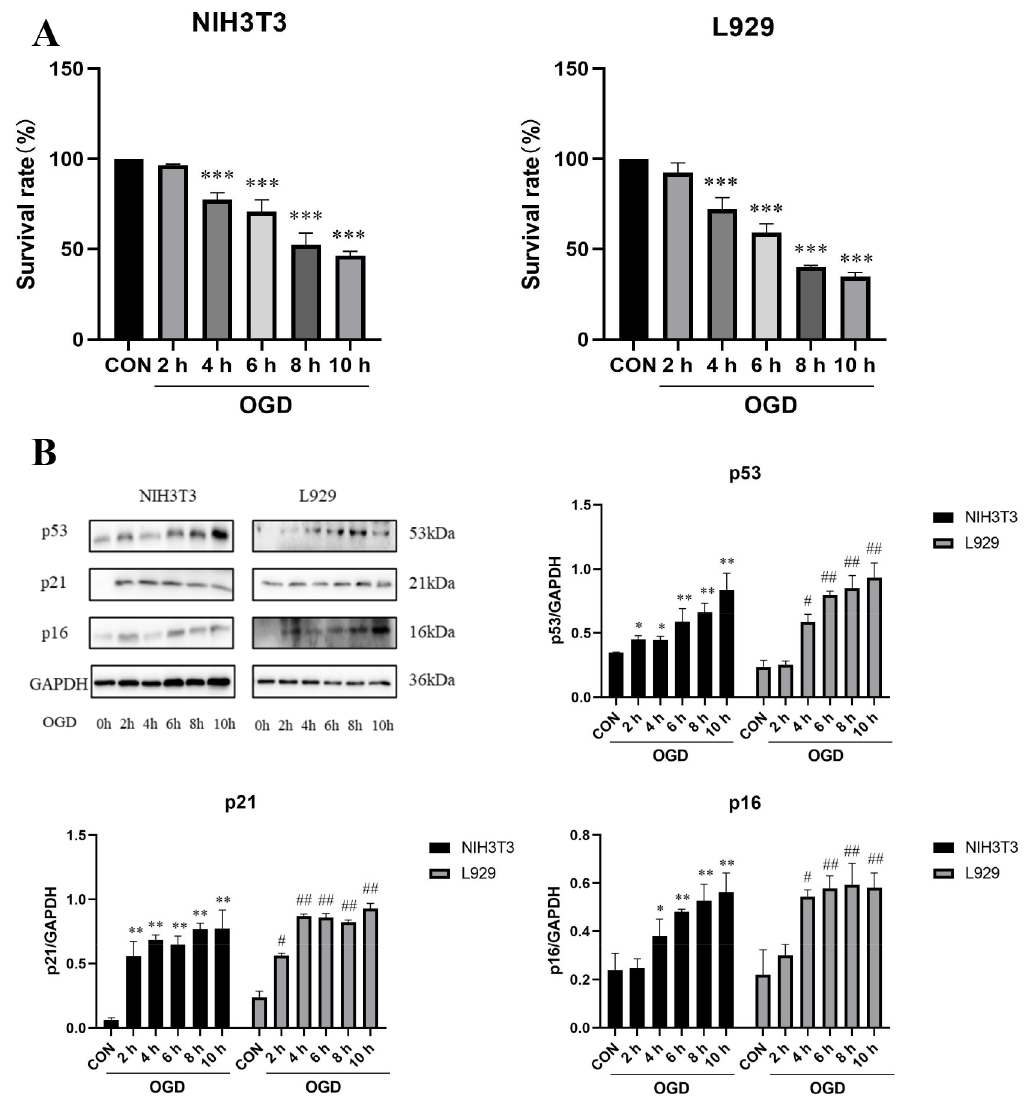
Figure 1. OGD promoted fibroblast senescence. ( A ) Survival rates of NIH3T3 and L929 cells under oxygen–glucose deprivation (OGD) conditions for 0 h, 2 h, 4 h, 6 h, 8 h, and 10 h detected by MTT assay. OGD—oxygen–glucose deprivation; CON—control. The results are presented as the means ± SDs, and Student’s t-test was used to determine the p -value. * p < 0.05, ** p < 0.01, and *** p < 0.001, compared with CON group. ( B ) Western blot analysis and densitometric analysis of p53, p21, and p16 protein levels in NIH3T3 and L929 cells under OGD conditions for 0 h, 2 h, 4 h, 6 h, 8 h, and 10 h. GAPDH was used as the loading control. OGD—oxygen–glucose deprivation; CON—control. The results are presented as the means ± SDs, and Student’s t -test was used to determine the p -value. * p < 0.05, ** p < 0.01, and *** p < 0.001, compared with CON group in NIH3T3 cells; # p < 0.05 and ## p < 0.01, compared with CON group in L929 cells. To further detect the dynamic changes in collagen expression in NIH3T3 and L929 cells after different treatment periods of OGD, we detected the changes in collagen mRNA and protein levels. The results show that compared with the control group, the mRNA levels of collagen I and collagen III in NIH3T3 and L929 cells increased significantly after OGD treatment for 6, 8, and 10 h (Figure 2A). Collagen I, collagen III, and α -SMA protein expression increased significantly (Figure 2B). In conclusion, OGD can promote senescence and collagen expression in